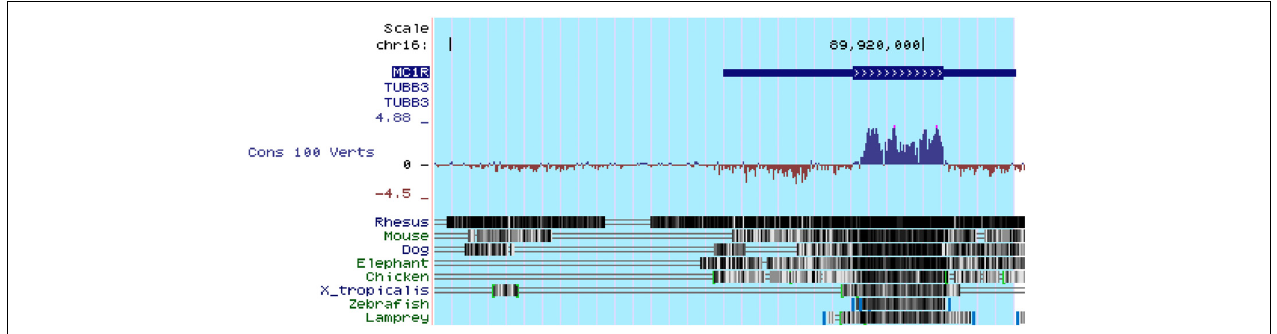
FIGURE 6 | All of the five types of melanocortin receptors are encoded by intronless genes, as exemplified here by the MC1R gene. MC1R is located at chr16:89,914,847-89,920,951. As shown above in genomic annotation of MC1R with UCSC Genome Browser (GRCh38/hg38), MC1R is highlighted and there is no intron in MC1R. Comparative Genomics indicated that MC1R is highly conserved among different species